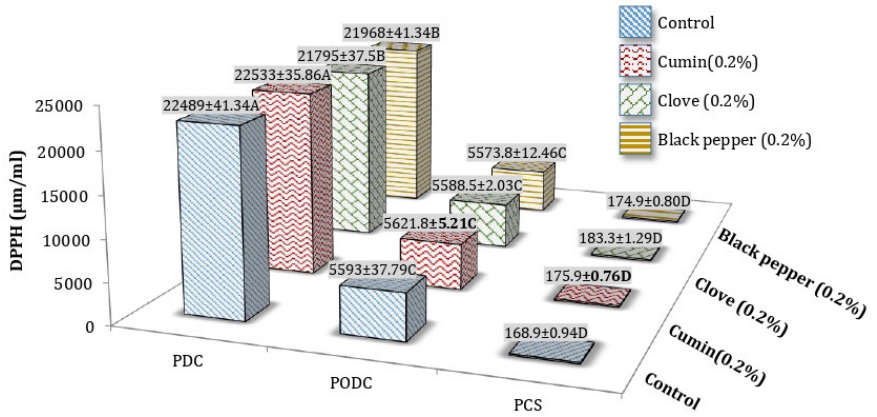
Figure 7. Mean values for DPPH (Radical Scavenging Activity) (µmol/mL Trolox equivalent) of processed Cheddar cheese (PCS), orally digested (PODC) and duodenal digested Cheddar cheese (PDC) made from buffalo milk after ripening. A–D means followed by the same letter for the same parameter are not significantly different ( p < 0.05).